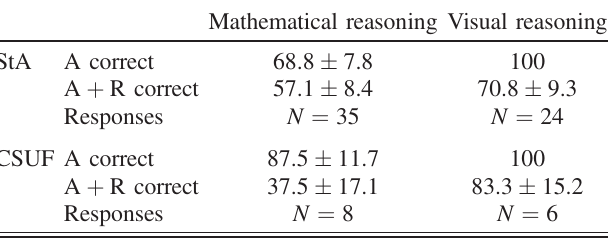
TABLE V. The percentage of post-test responses to part b with the correct answer ( “ A ” , top row) and both correct answer and reasoning ( “ A þ R ” , middle row), separated into students who used mathematical reasoning or visual reasoning. Responses that included both mathematical and visual reasoning are included as visual reasoning in the table. The bottom row shows the number of responses used to determine each of the percentages. The responses are shown for StA ( N ¼ 64 ) and CSUF ( N ¼ 22 ) students separately. Errors are the standard errors of a